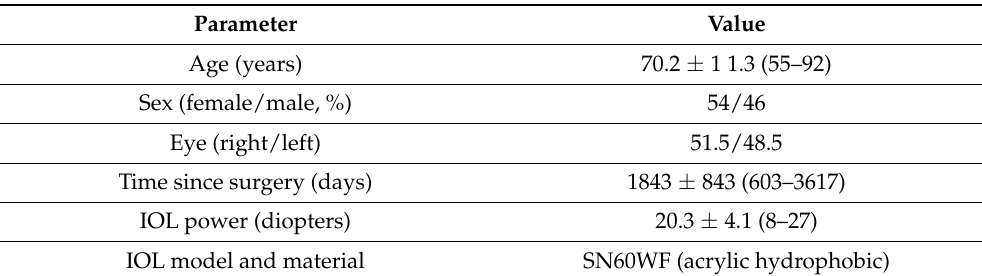
Table 1. Demographics of the patients and intraocular lenses (IOL) included in the present study. Mean ± standard deviation (range).